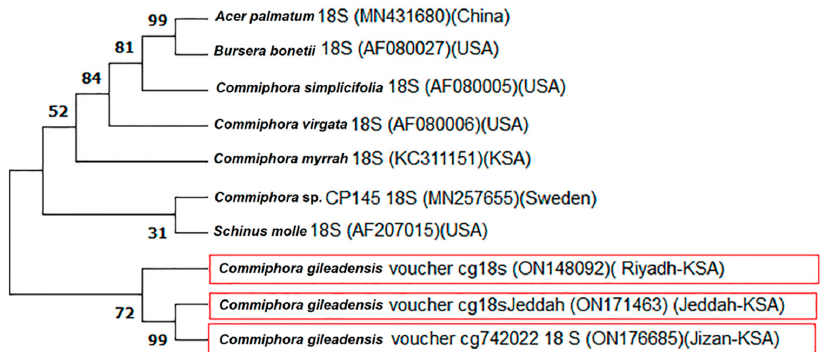
Figure 1. Phylogeny tree for C. gileadensis accessions in KSA from ITS sequences (highlighted in red) compared with other relatives of the closest species obtained from GenBank from different localities. Bootstrap tests were performed with 2000 replications.